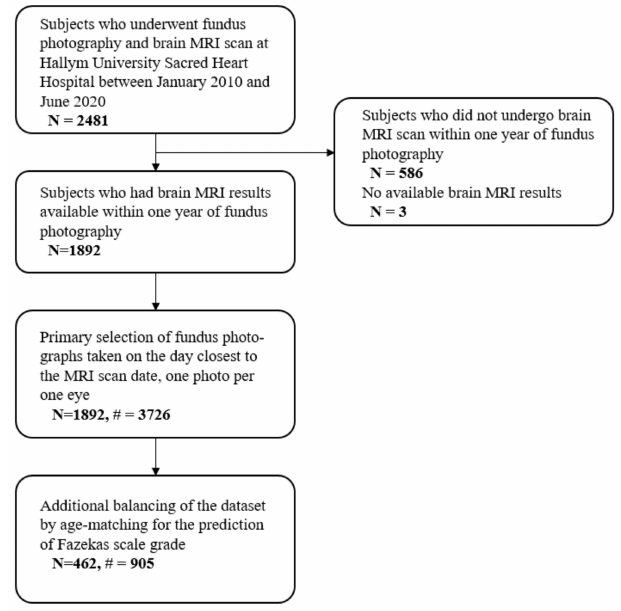
Figure 1. Flowchart of participant enrollment. #, number of